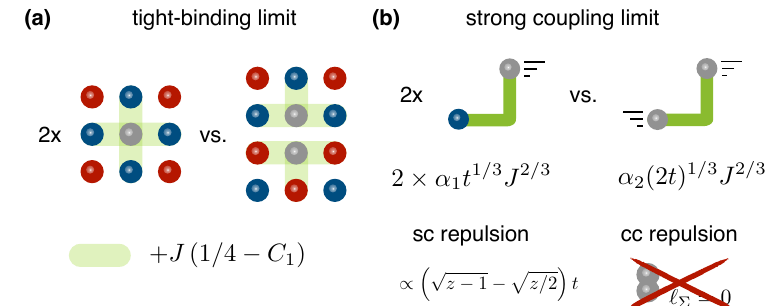
Figure 11: Binding energy from the effective theory, predicted for the t − J model. z = 0,1,2 sectors, = 0,..,3 and m ( 1 ) We used the truncated basis including all m 4 3 and string lengths up to ℓ (as indicated in the plot). The string potential was max calculated for an Ising background. Around k = 0 there is no coupling to rotational states for the indistinguishable holes and a linear string theory allows to work with = 10 3 . much longer maximum string lenghts ℓ max